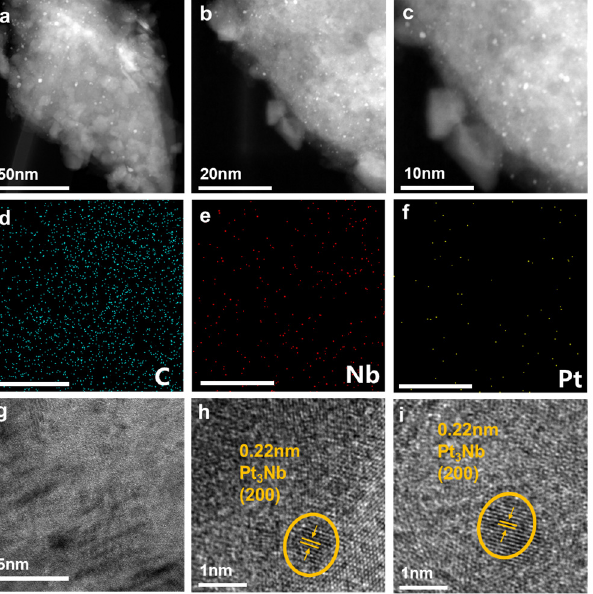
Figure 2. ( a – c ) TEM images of Pt/Nb 2 CT x -600; ( d – f ) EDS mapping images of Pt/Nb 2 CT x -600 (scale bar: 50 nm); ( g – i ) HRTEM of Pt/Nb 2 CT x -600.